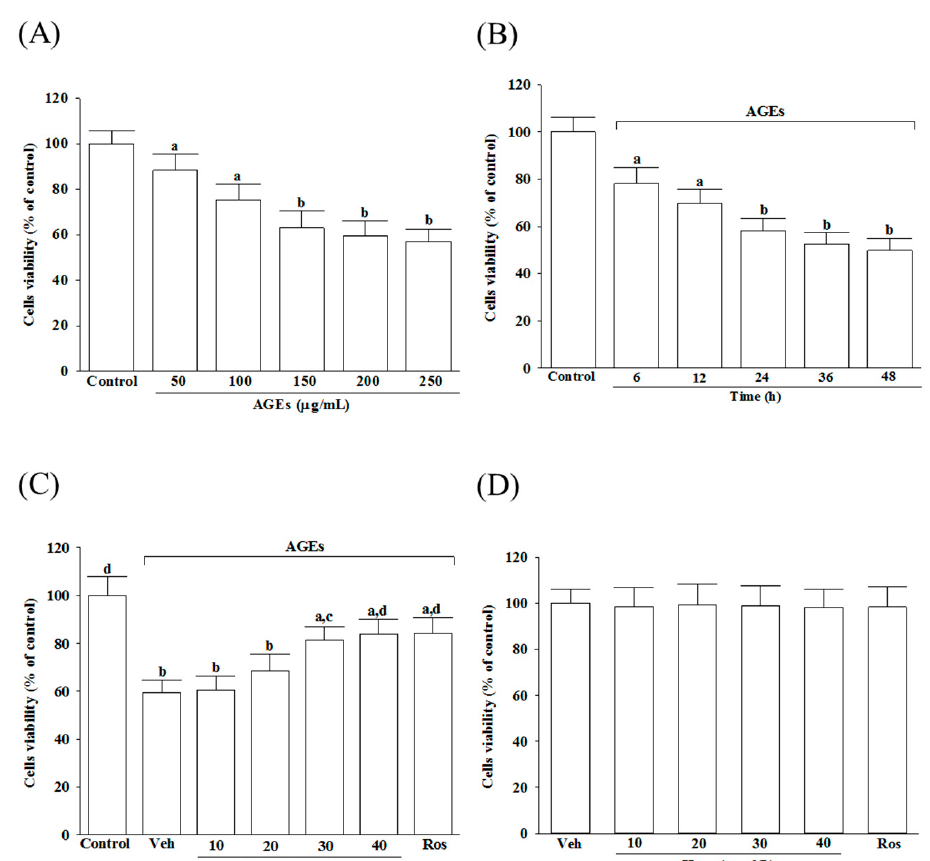
Figure 1. Changes to the reduced cell viability in AGE-induced SH-SY5Y cells. ( A ) SH-SY5Y cells were received 24 h prior to AGE exposure at various concentrations. ( B ) Incubation of SH-SY5Y cells with 200 μ g/mL of AGEs for various periods. ( C ) Treatment of SH-SY5Y cells for 1 h with indicated concentrations of hesperetin (hesp; 10–40 μ mol/L) or rosiglitazone (Ros; 10 μ mol/L); after that, exposure to 200 µ g/mL of AGEs for another 24 h. ( D ) Incubation of SH-SY5Y cells with indicated concentrations of hesp (10-40 µ mol/L) or Ros (10 µ mol/L) for 24 h without 200 µ g/mL of AGE exposure. An MTT assay used cell viability determination; the value was expressed as a percentage of the control group from untreated cells. The results are presented as the mean ± SD of five independent experiments performed triplicate (n = 5). a p < 0.05 and b p < 0.01 when compared to the data from the untreated control group (control). c p < 0.05 and d p < 0.01 when compared to the data from the vehicle (Veh)-treated cells.